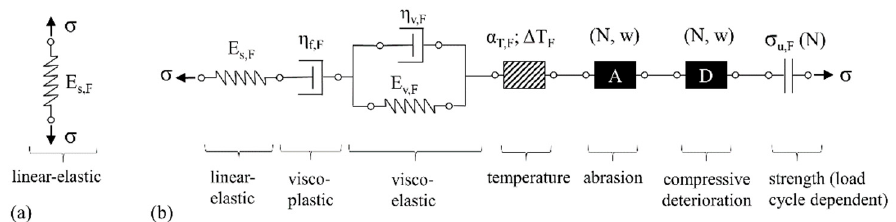
Figure 16. Rheological models of the fibre: ( a ) original model according to [32], ( b ) suggested extension including known damage mechanisms.